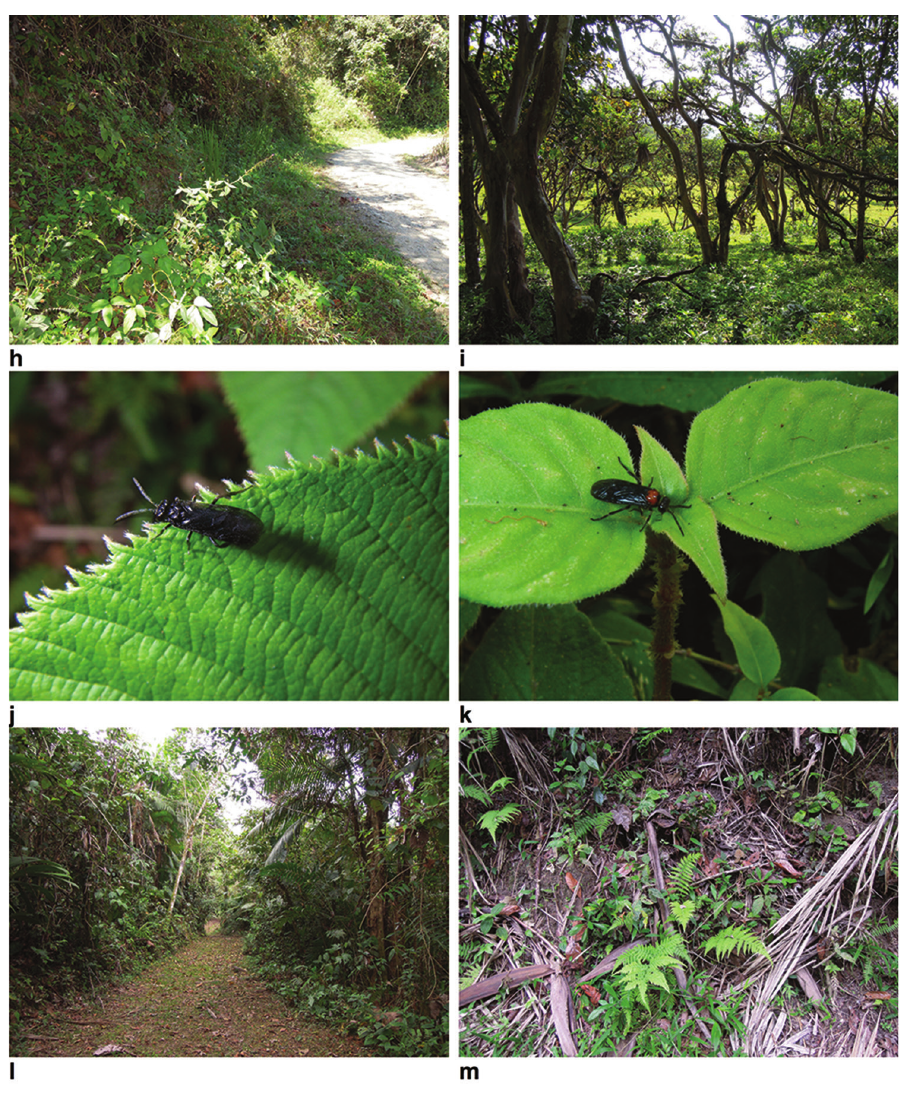
Figure 1. Continued. h Biotope where Waldheimia sp. A was common i Biotope of pasture (with orchard in the foreground) where, among others j Inea sp. (P4239.E) and k Waldheimia sp. A were collected l Bio- tope of forest path m with the precise spot where Stromboceros sutilis (P4239.G) was Ptenos delta (Malaise, 1957) Fig. 4 Material. Estación científica Yasuní, near río Tiputini, 00°40'S, 076°24'W, 220m, 02.03.2015, P4119.C (1 ♀ ), leg. T. Delsinne. Note. This is a new record for Ecuador. It was previously known only from Brazil and Peru (as Hemidineura delta Smith, 1992).